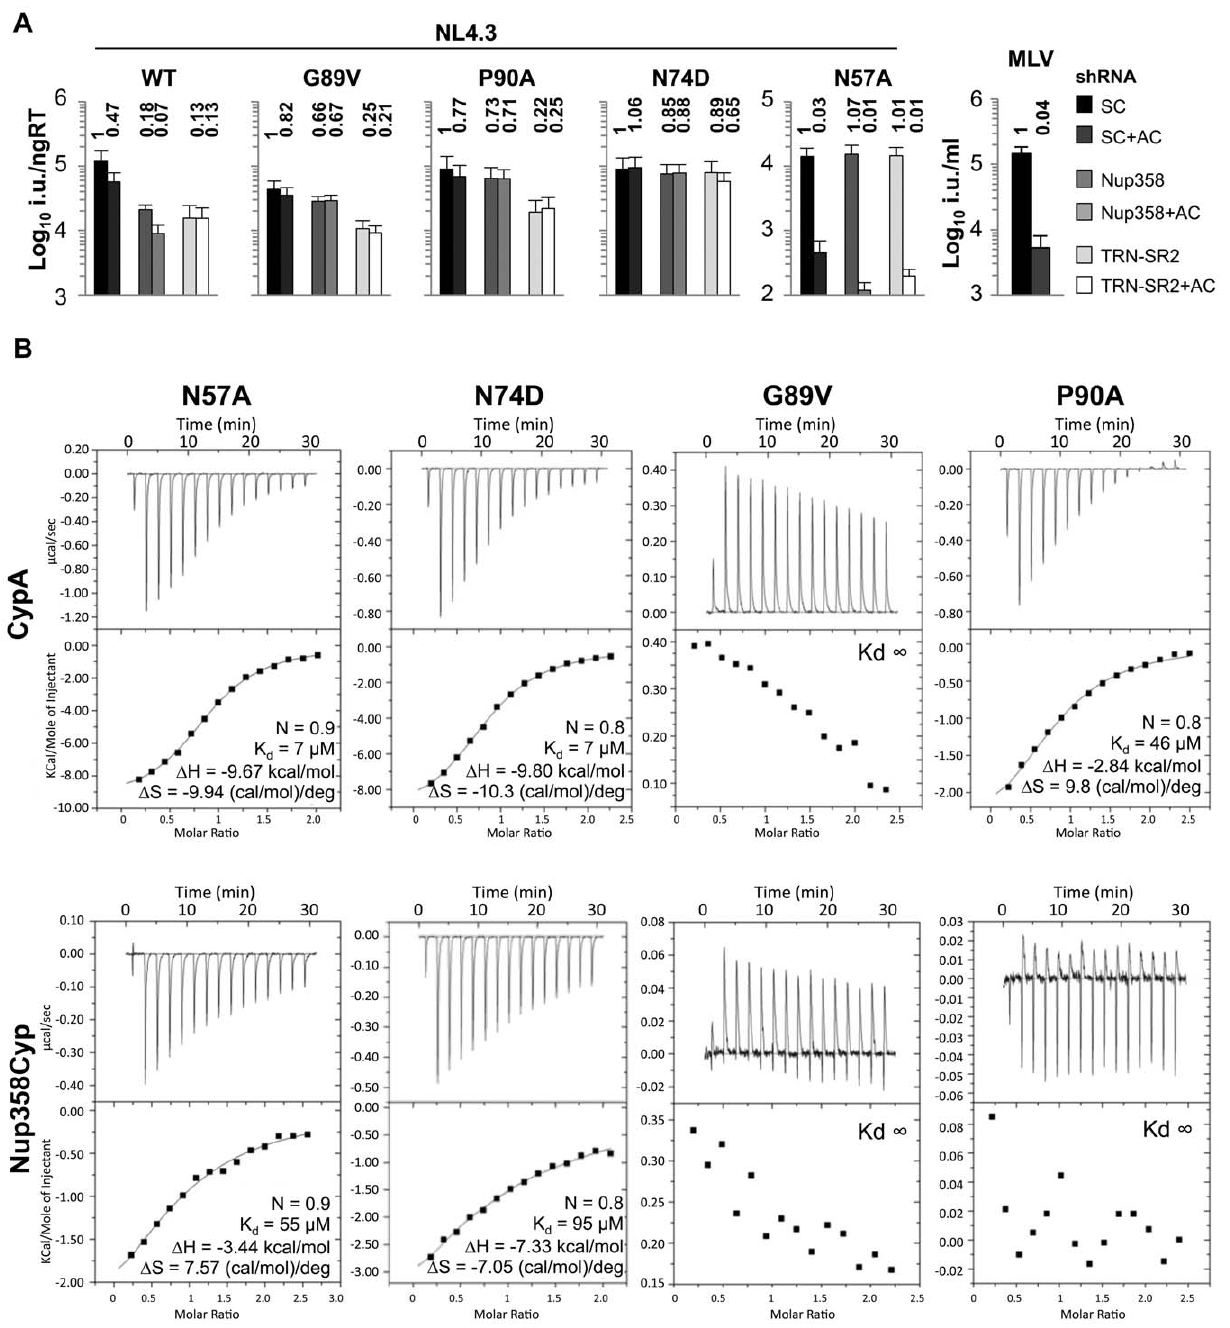
Figure 3. Effect of CA mutants on Nup358/TRN-SR2 RNAi sensitivity and Nup358Cyp binding. A , Titers of VSV-G pseudotyped NL4.3 HIV- 1 GFP vectors bearing wild type or mutant CA on HeLa control cells (SC), or Nup358 or TRN-SR2 depleted cells in the presence or absence of 2 m g/ml aphidicolin (AC). MLV GFP vector was used as a control for aphidicolin. Relative changes from titer on control cells are shown above the bars. The data are representative of two independent experiments each using three different virus doses. B , ITC of human CypA and Nup358-Cyp against HIV-1 CA NTD mutants. K d values as well as stoichiometries (N), enthalpies ( D H) and entropies ( D S) are shown.